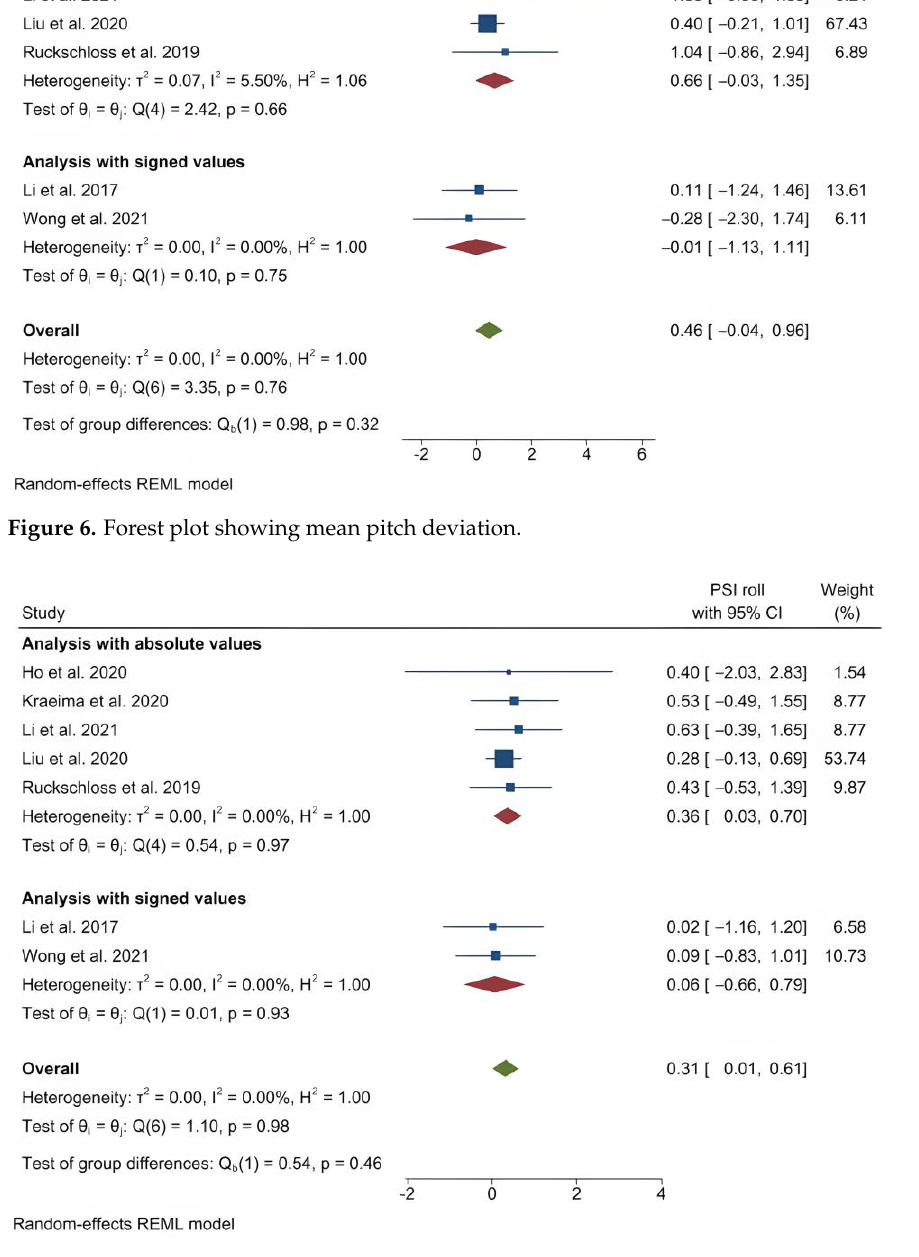
Figure 7. Forest plot showing mean roll deviation.